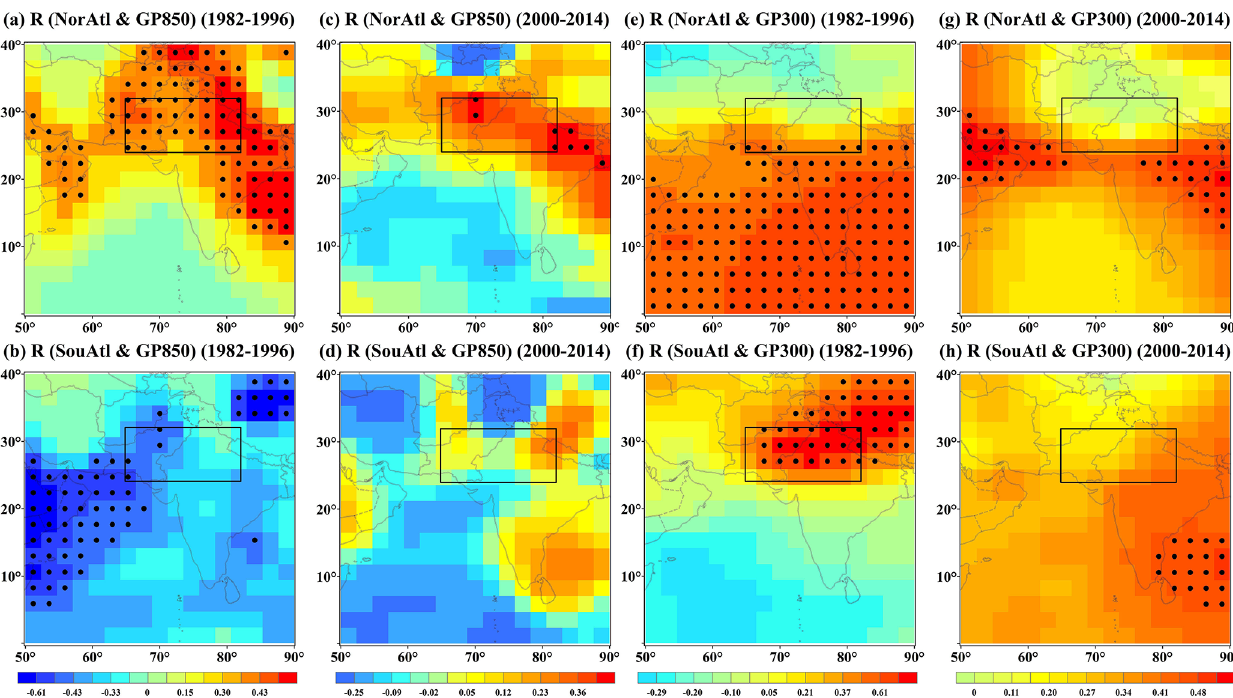
Figure 6. Correlation between spring (March–May) tropical North and South Atlantic SSTA (NorAtl/SouAtl) with the ENSO signal removed and geopotential height (GP) at 850hPa (a–d) as well as 300hPa (e–h) in the dust season (June–July). (Correlations that passed the 90% confidence level were marked by black dots.)